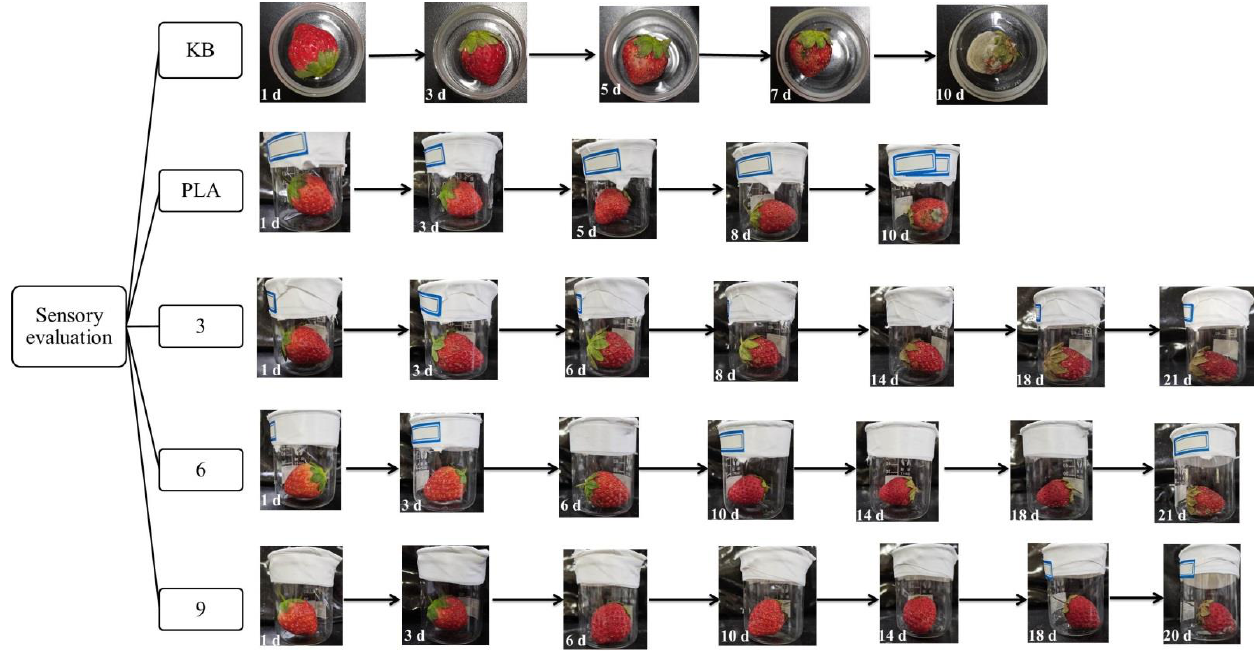
Figure 9. the fresh-keeping effect of blank no film, pure PLA film, and antioxidant food packaging